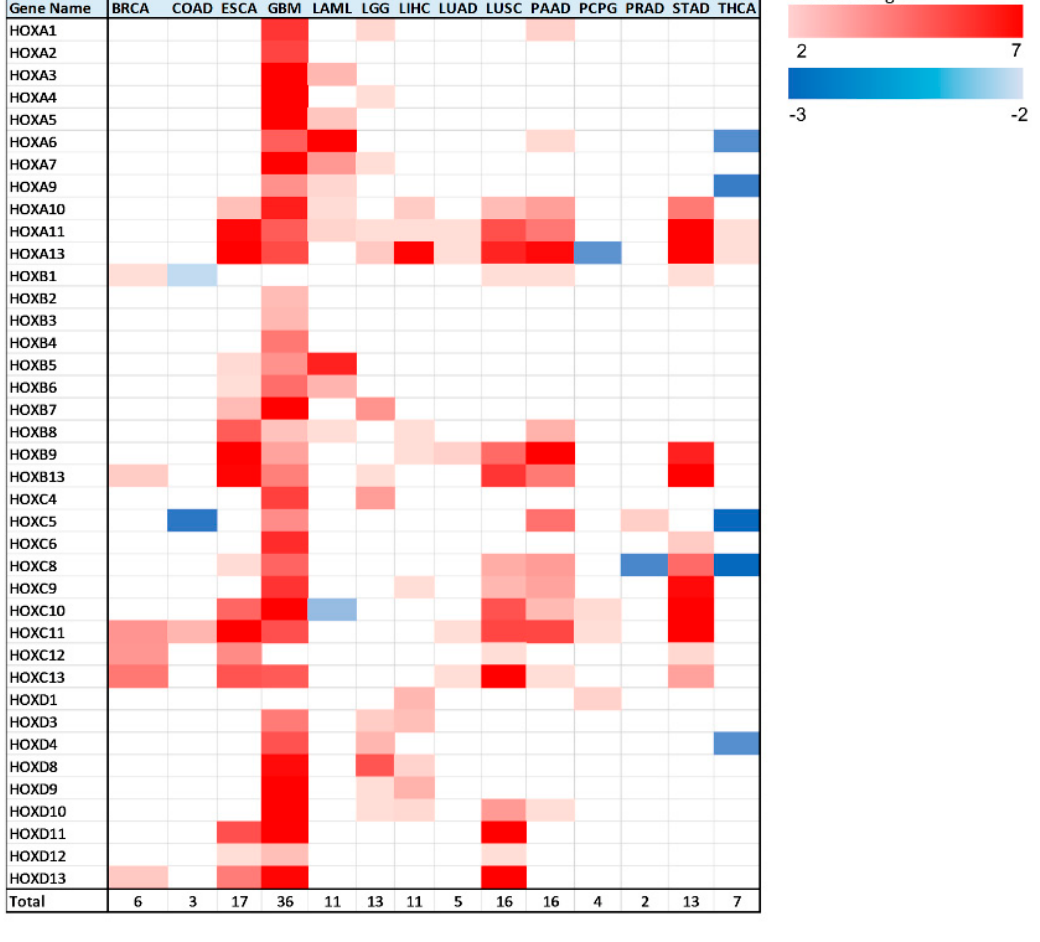
Figure 4. Heatmap of differentially expressed HOX genes in different cancer types. Gene column includes list of all 39 HOX genes tested in this analysis. The rest of the columns represent the analyzed cancer types. Upregulated genes are marked in red color gradient (light red represents lower fold change), downregulated genes are marked in blue color gradient (light blue represents lower fold change).